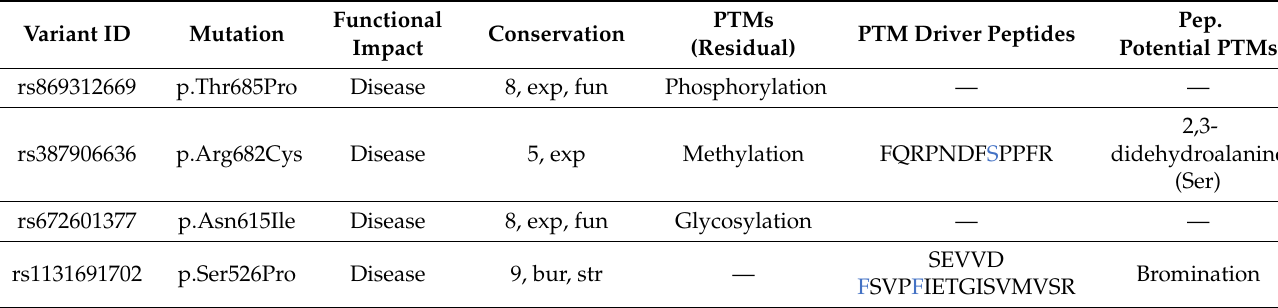
Figure 2. Conservation analysis by ConSurf server. Table 4. Summary of the most deleterious